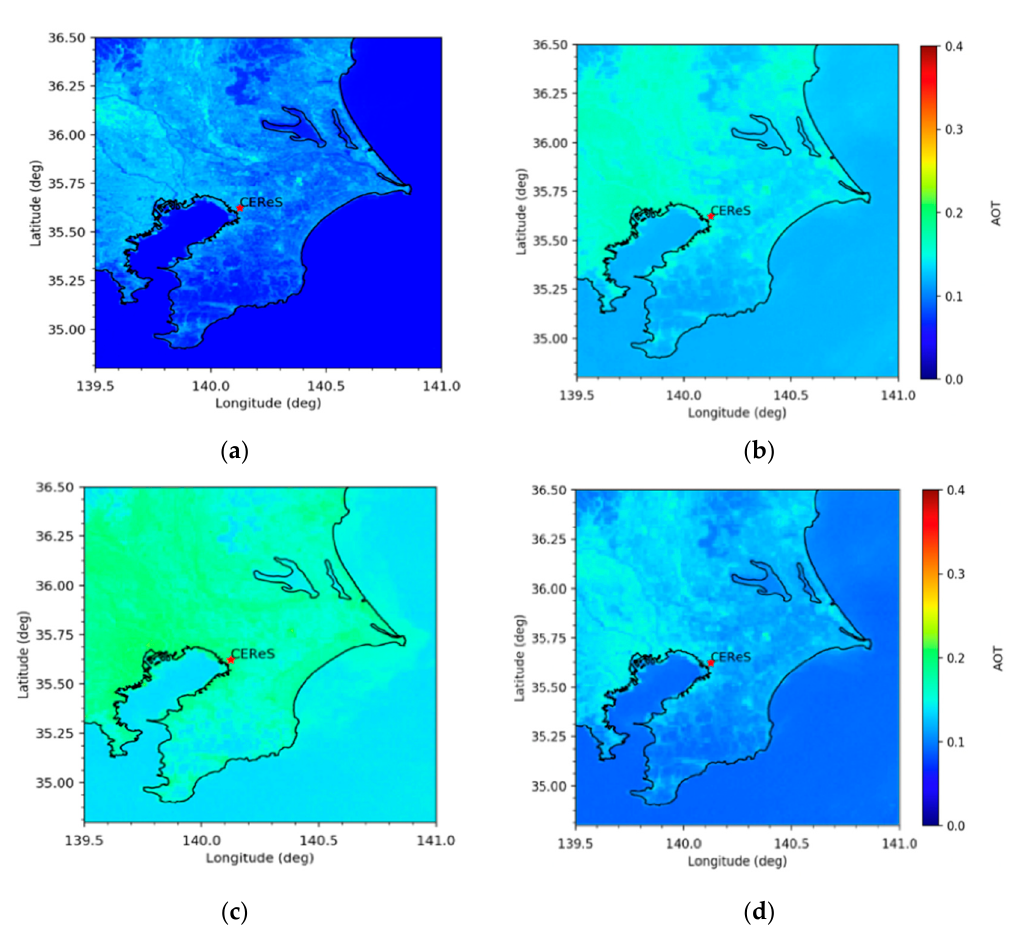
Figure 8. Spatial distributions of the AOT retrieved from the Himawari-8 band 1 on clear-sky conditions: 6 January 2020 ( a ), The comparison of values of AOTs retrieved at 550 nm is shown in Figure 8 for pixels over both the Chiba city area and Tokyo Bay area. The AOT from Himawari-8